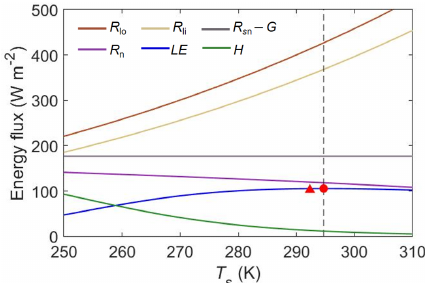
Figure 3. Variation of energy fluxes with T s . Plot shows how the en- ergy fluxes vary with T s for a fixed value of R sn − G at 176.6Wm − 2 ( R sn is the net shortwave radiation; see Eq. 4 in Sect. 2.2). The red dot indicates the maximum evaporation and the red triangle shows the observed evaporation. The T s at which the maximum evapora- tion occurs is shown by the dashed vertical